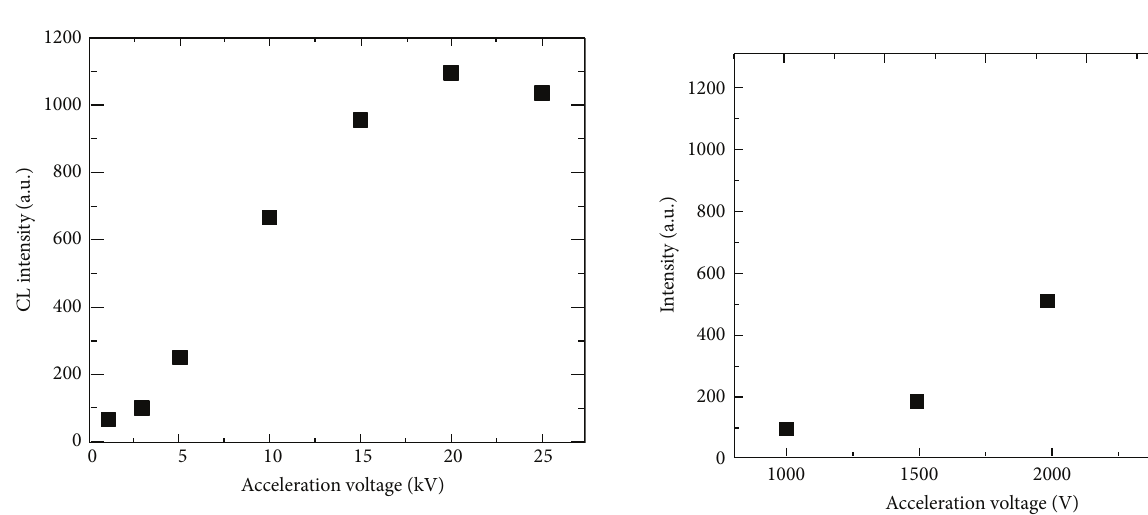
Figure 4: Emission spectra of the lamp at acceleration voltages ranging from 1 to 2.5 kV.